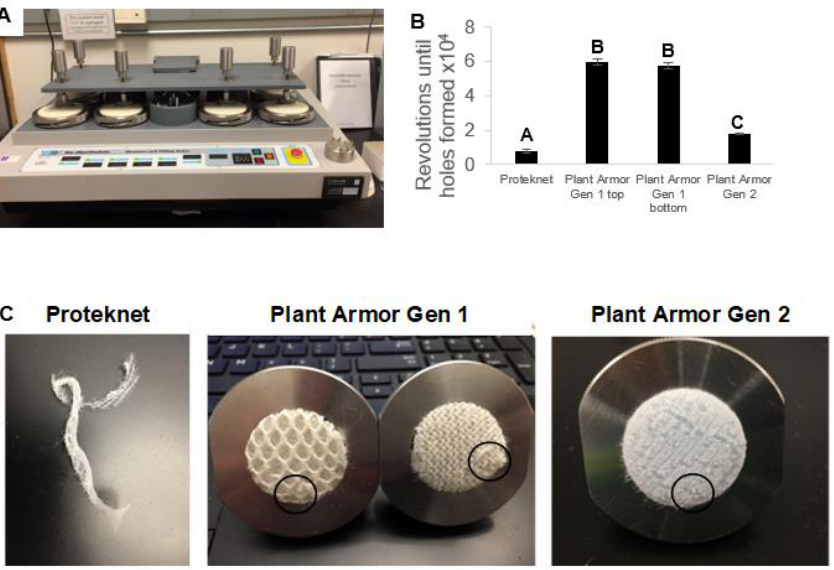
Figure 4. ( A ) Martindale abrasion device; ( B ) number of revolutions to reach the abrasion endpoint; and ( C ) abrasion endpoints. The endpoint was reached for Plant Armor when the first beginning of a visible hole was seen as shown by the circles in ( C ). The endpoint for Proteknet is shown in ( C ). In ( C ) for Generation (Gen) 1, the textile top surface is shown on the left and the bottom on the right (bottom = surface facing the covered plant). Error bars are ± 1 SEM. Treatments that were statistically significantly different as determined by ANOVA and Tukey’s test are indicated by different letters on the bar